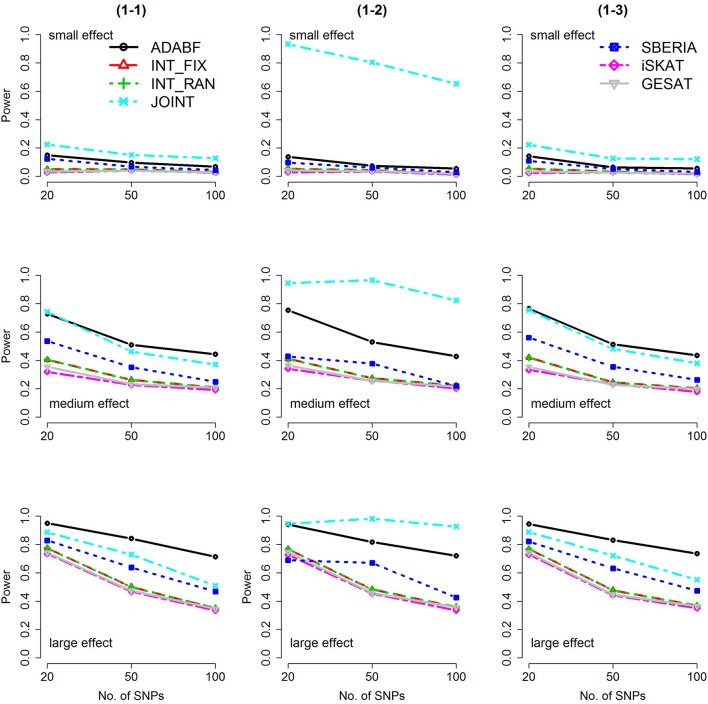
Power of the seven tests for continuous traits (1 SNP × E). The x-axis represents the number of SNPs in the gene, whereas the y-axis depicts the power at the nominal significance level α = 2.5 × 10−6. From the top row to the bottom row, the magnitudes of SNP main effects and SNP × E interaction effects were evaluated at three levels: small, medium, and large, respectively.